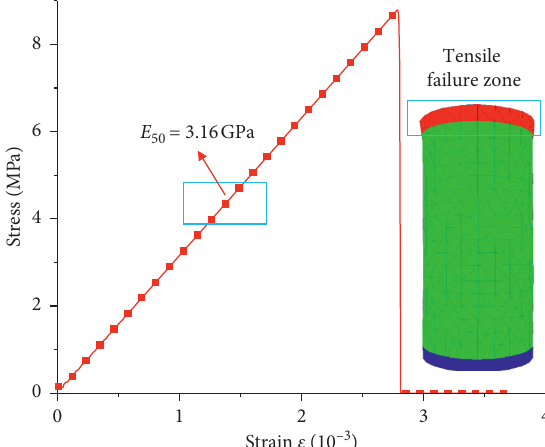
Figure 4: Uniaxial tensile stress-strain curve of the numerical simulation. Table 3: Test and numerical simulation of tensile strength. Numerical Test simulation